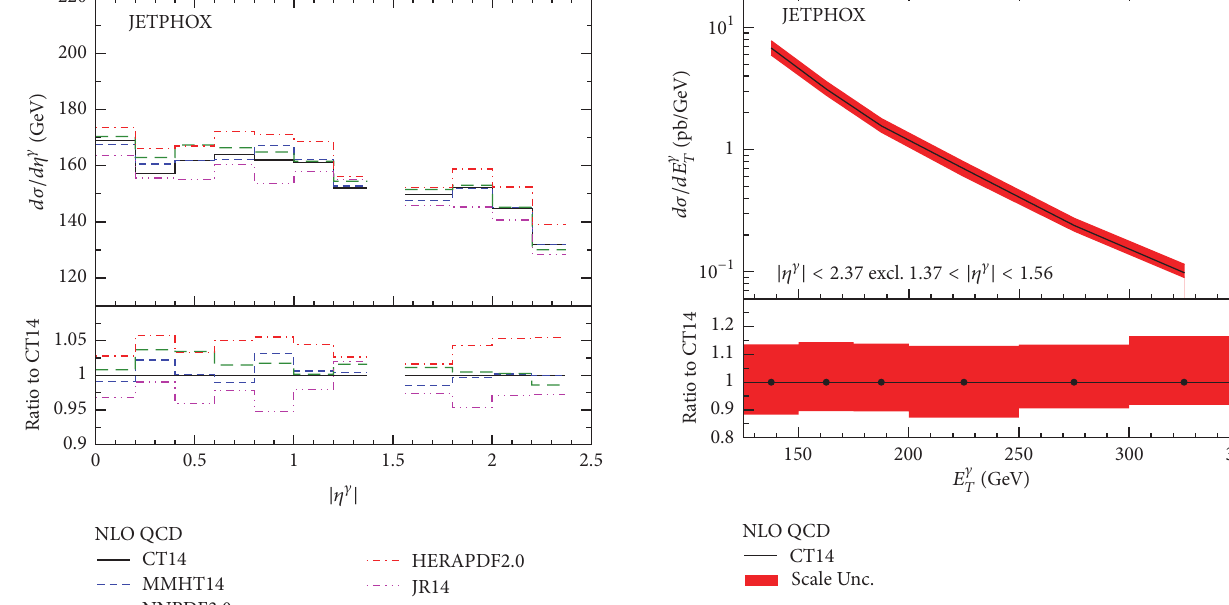
Figure 4: Same as Figure 3, but as a function of 𝜂 𝛾 .